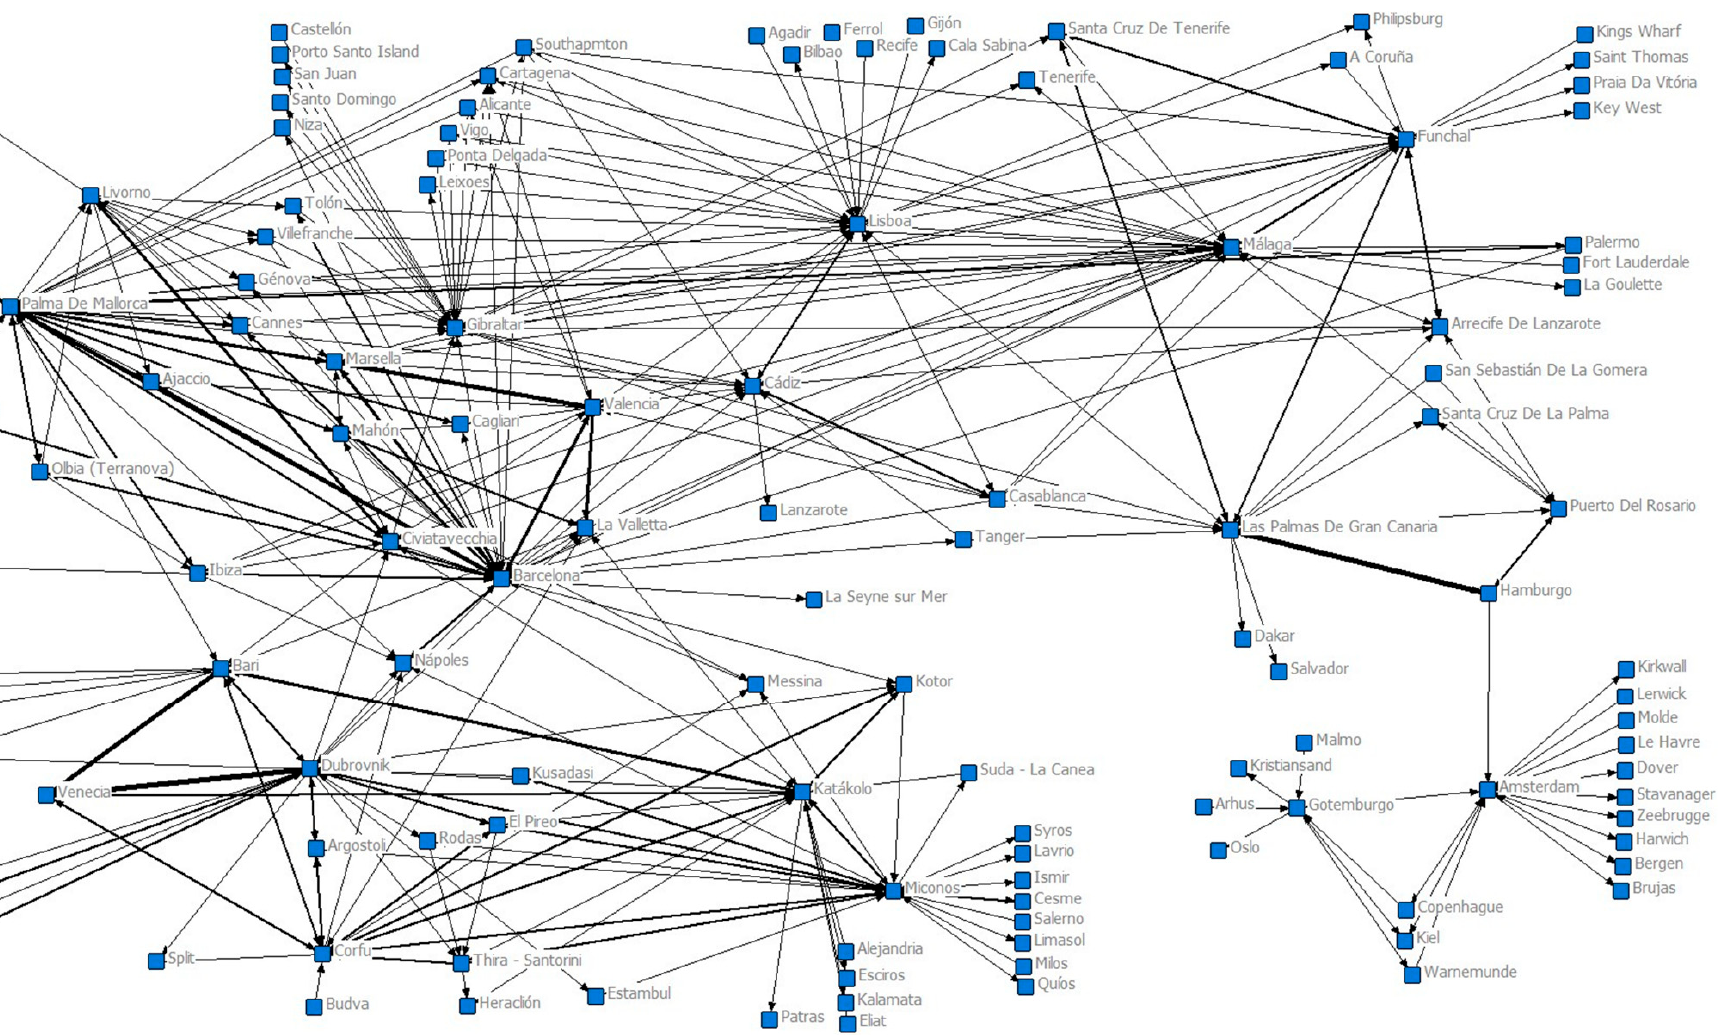
Figure 4. Interrelations in the contemporary cruise port network in Southern Europe in 2016. Source: Authors elaboration. Note: The thickness of the lines indicates the traffic intensity between ports.